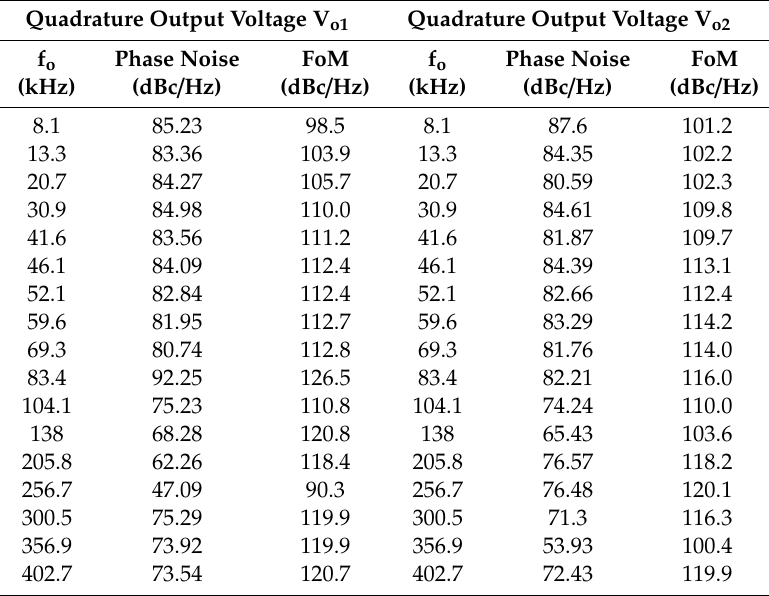
Table 4. Phase noise performance measured at di ff erent oscillator frequencies.